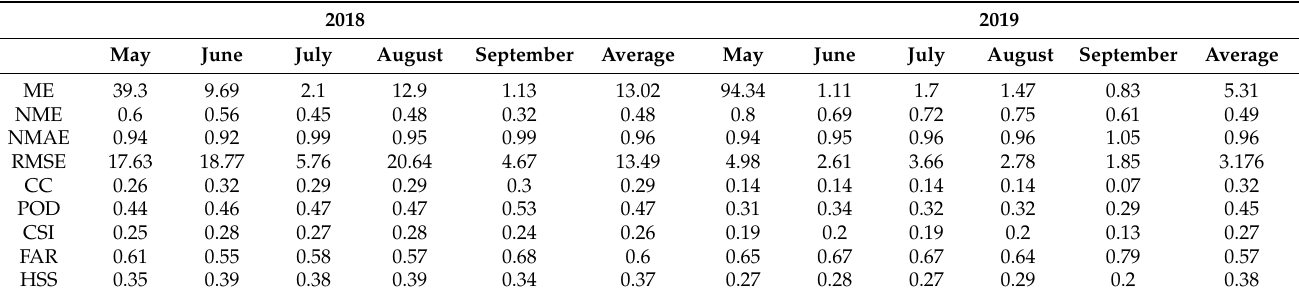
Table 6. Evaluation results of hourly rainfall accumulations